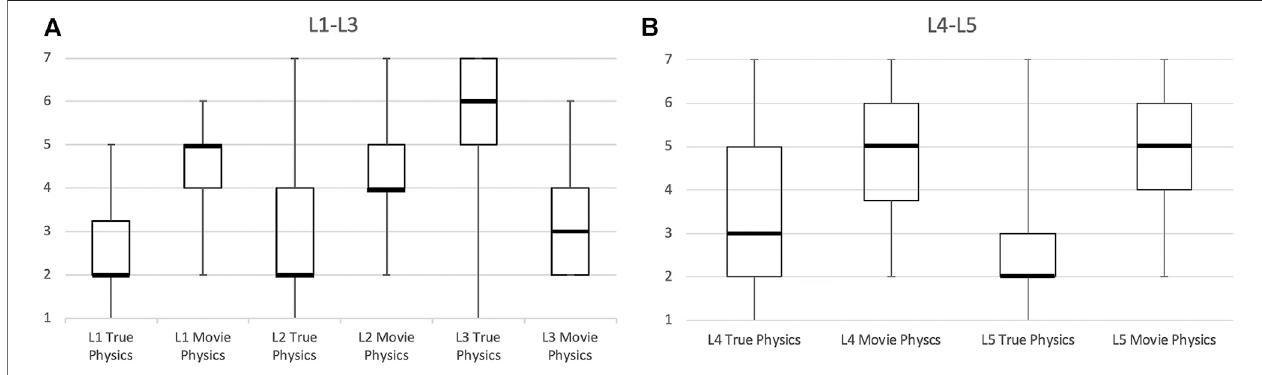
FIGURE 9 | Study 2 Likert responses L1-L3 (A) and L4-L5 (B) visualized as box plots, interquartile ranges and minimum and maximum responses. In (A) , responses closer to 4 are perceived as closer to realism, whereas in (B) responses closer to 7 are perceived as closer to realism.